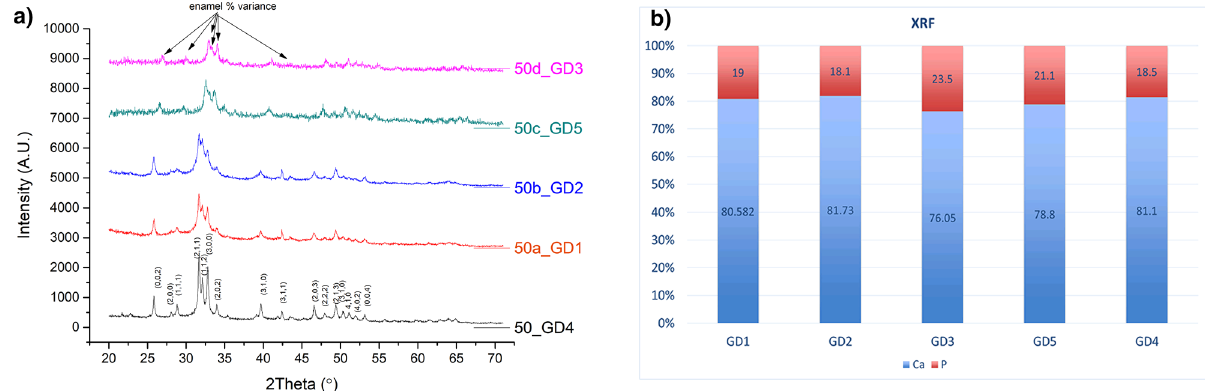
Figure 3. ( a ) Measures at Bruker AXS equipment details the expected angles of the x-ray bean diffraction, CIFs obtained from ICSD—https:// icsd. produ cts. fiz- karls ruhe. de/), treated at Topas 4.2 also from Bruker, and plotted using Origin 2015. As it is a complex multi-atomic molecular structure, several angles are represented, but with higher incidence on angles near 26, 32–33, and 40 degrees, the reminiscence of angles positions means no molecular arrangement modification was detected. ( b ) XRF’s data obtained at Bruker’s S2 Ranger equipment the graphic was generated at Excel 2013—the sterilization methods present different effects on the composition balance (Ca/P), indicating GD3 (EO) affects more the Ca portion of Hydroxyapatite and GD2 (DH) interacts more intensively with P portion.